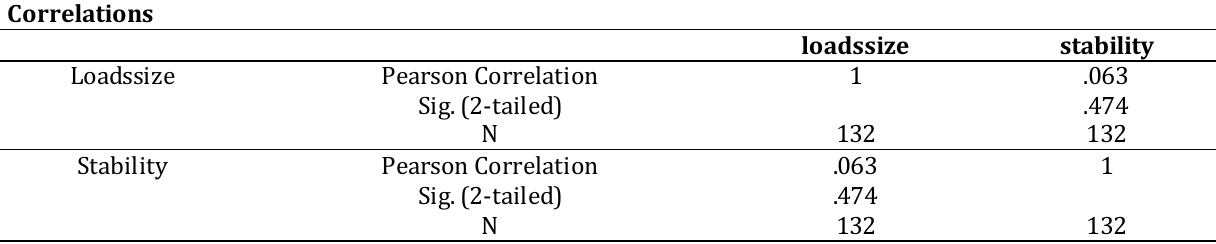
Table 3: Load size and Stability relationship (No cargo)